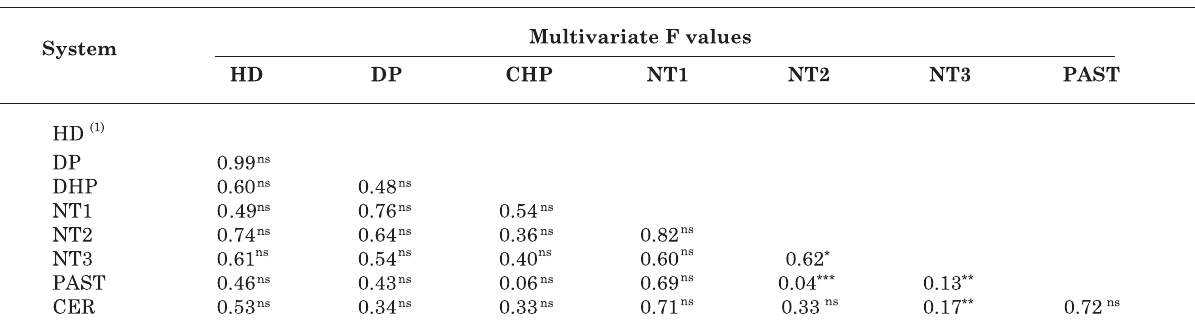
Table 4. Multivariate F values for comparison of the regression models of the variable POC between the treatments